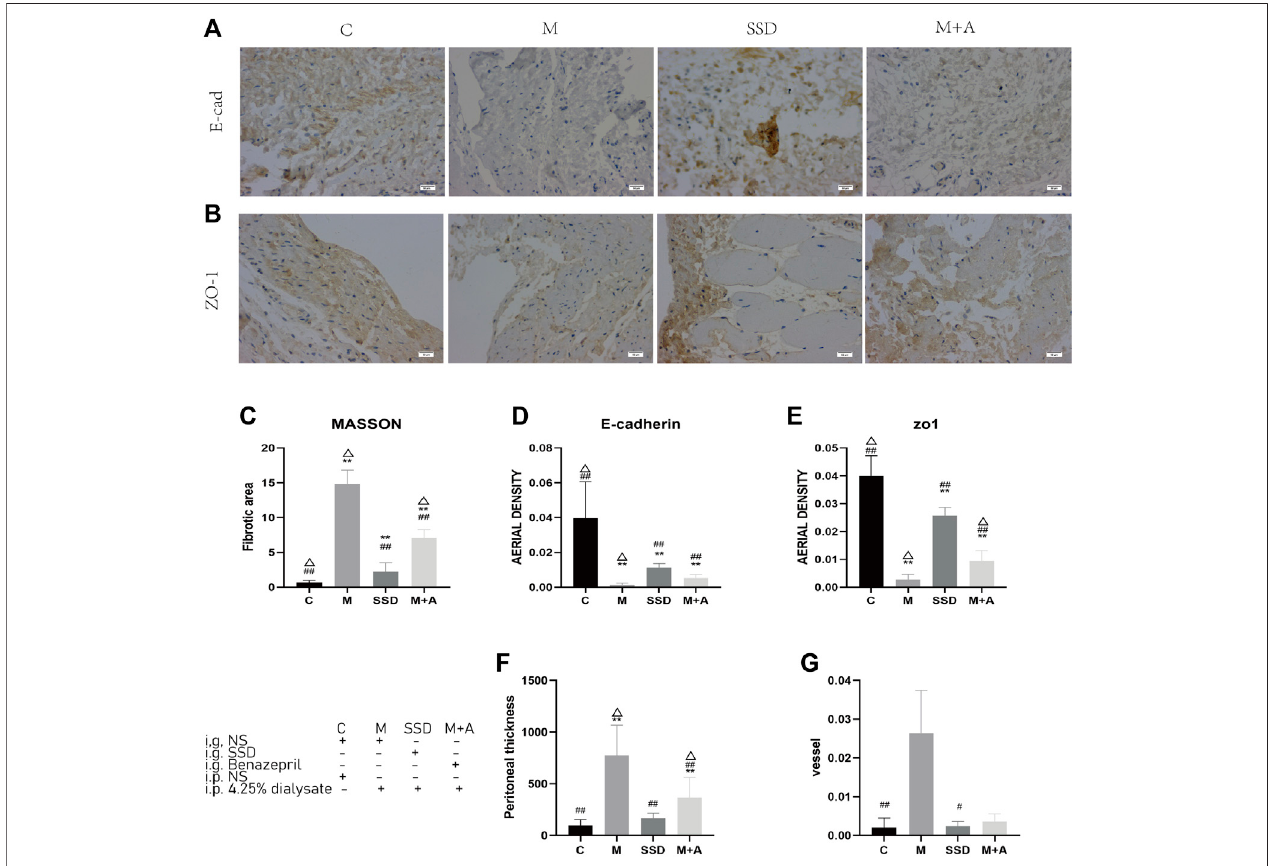
FIGURE 2 | (A , B) Immunohistochemichal staining of E-cadherin (200 × ) and ZO-1 (200 × ) in the peritoneum of the experimental groups. (C) Semi-quantitative analysis of the average optical density of the fi brotic area, based on Masson staining (D) Semi-quantitative analysis of the average optical density of E-cadherin immunostaining (E) Semi-quantitative analysis of the average optical density of ZO-1 immunostaining. (F) Semi-quantitative analysis of the thickness of the peritoneum. (G) Semi-quantitative analysis of the richness of blood vessels ( n (cid:2) 5 – 7). For comparison with group M ## indicates p < 0.01; for comparison with the C group, ** indicates p < 0.01; for comparison with the SSD group △ indicates p <